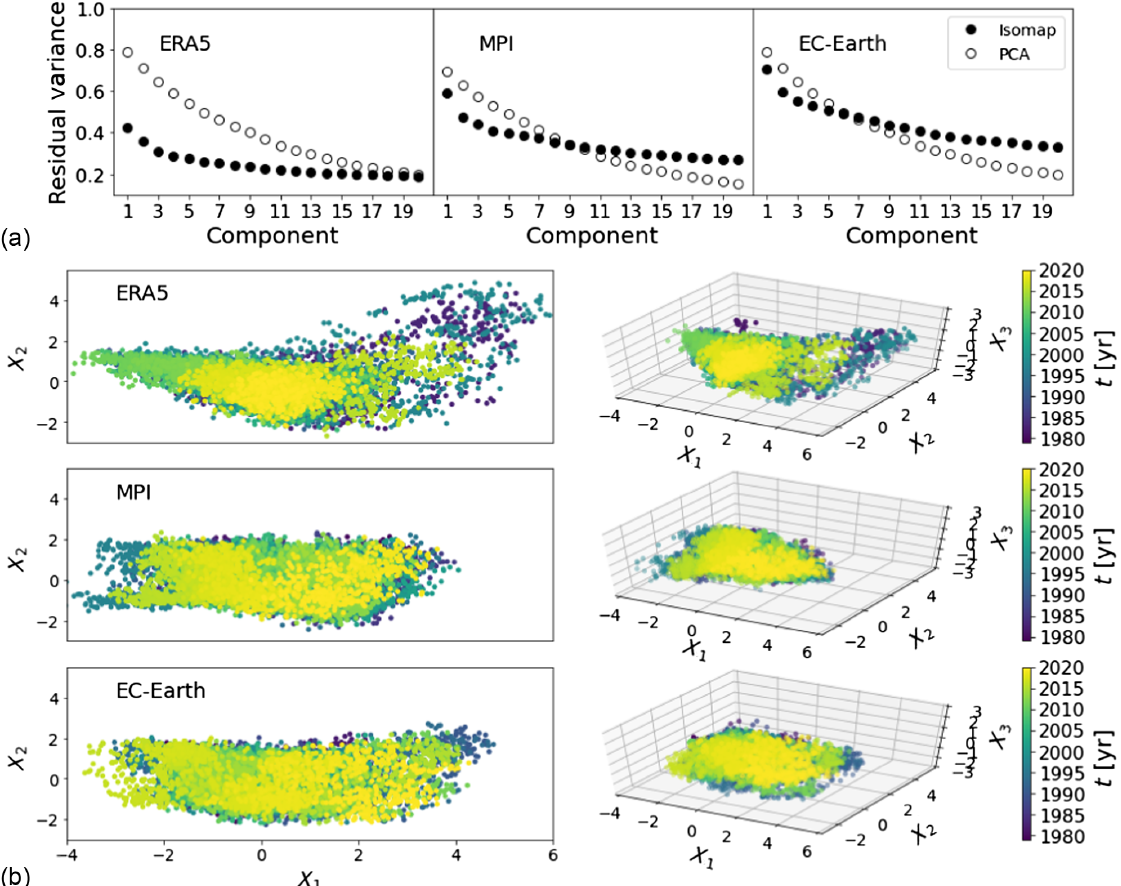
FIG. 2. Dimensionality reduction of the tropical Pacific Ocean anomalies (no linear trend and no seasonal cycle). (a) Residual variance of PCA and Isomap for observations (ERA5) and the two CMIP6 models (MPI and EC-Earth). (b) Low-dimensional, Isomap projections (first two or three components, respectively) of the three datasets; Isomap components are indicated as X 1 , X 2 , X 3 , respectively. Each point encodes the multivariate state of the tropical Pacific Ocean at a given day from January 1979 to December 2019. Projections have been standardized to unit